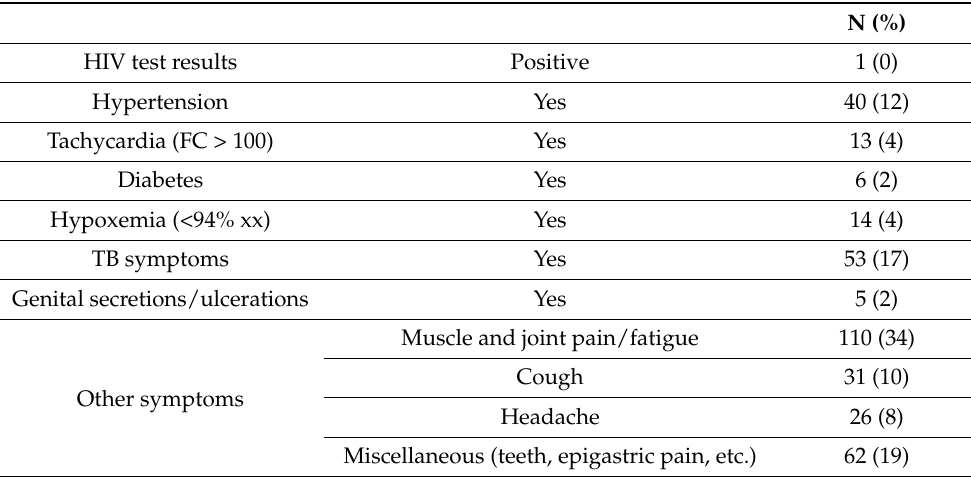
Table 3. HIV results and medical assessment performed on 321 migrants enrolled in the